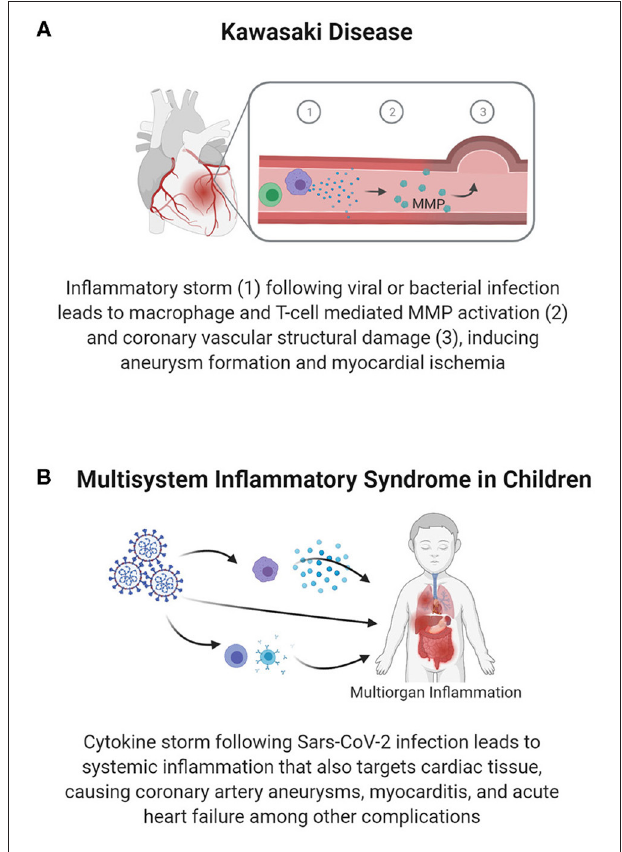
FIGURE 4 | Vascular inflammation-mediated pediatric cardiovascular disease. Inflammation following infection can lead to vascular damage and cardiac pathology. Inflammation and an associated immune response within the vasculature can cause vascular structural damage, as seen in coronary aneurysms in Kawasaki disease (A) , which reduces blood flow in the coronary arteries and predisposes individuals to premature MI. In Multisystem Inflammatory Syndrome in Children (B) , systemic inflammation causes damage to various organ systems, including targeting vascular and cardiac tissues to cause myocarditis, coronary artery aneurysms, and heart